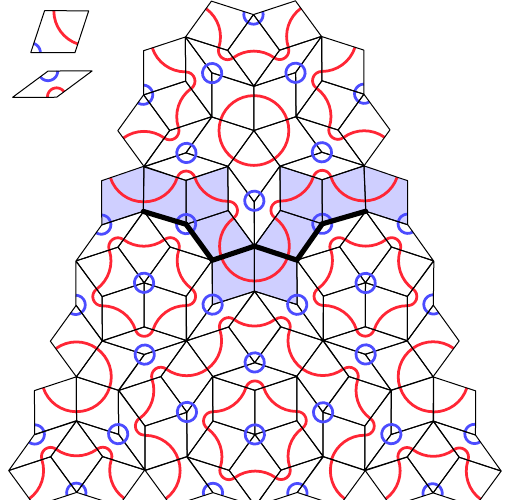
FIG. 9. Decorating the tiles with red and blue curves as indicated, continuity of the curves implies the matching rules of Fig. 2(a). At most, two red curves may cross the entire system [32,54]. All others must close around regions of D 5 symmetry. The curves follow chains of thick rhombuses, one of which is highlighted in blue (all thick rhombuses are adjacent to precisely two others). The curves also follow chains of second-nearest- neighbor even-valence vertices (monomer membranes): a 4-6-4 segment is highlighted with a thick black line. Therefore, these chains also close around regions of D 5 symmetry centered on either a 5 - or 5 -vertex. The thick black line can be seen to curve A B away from the 4-vertex with curvature 2 π = 5 and toward the 6- vertex with curvature − 4 π = 5 , with the directions of the vertices defined in Fig.